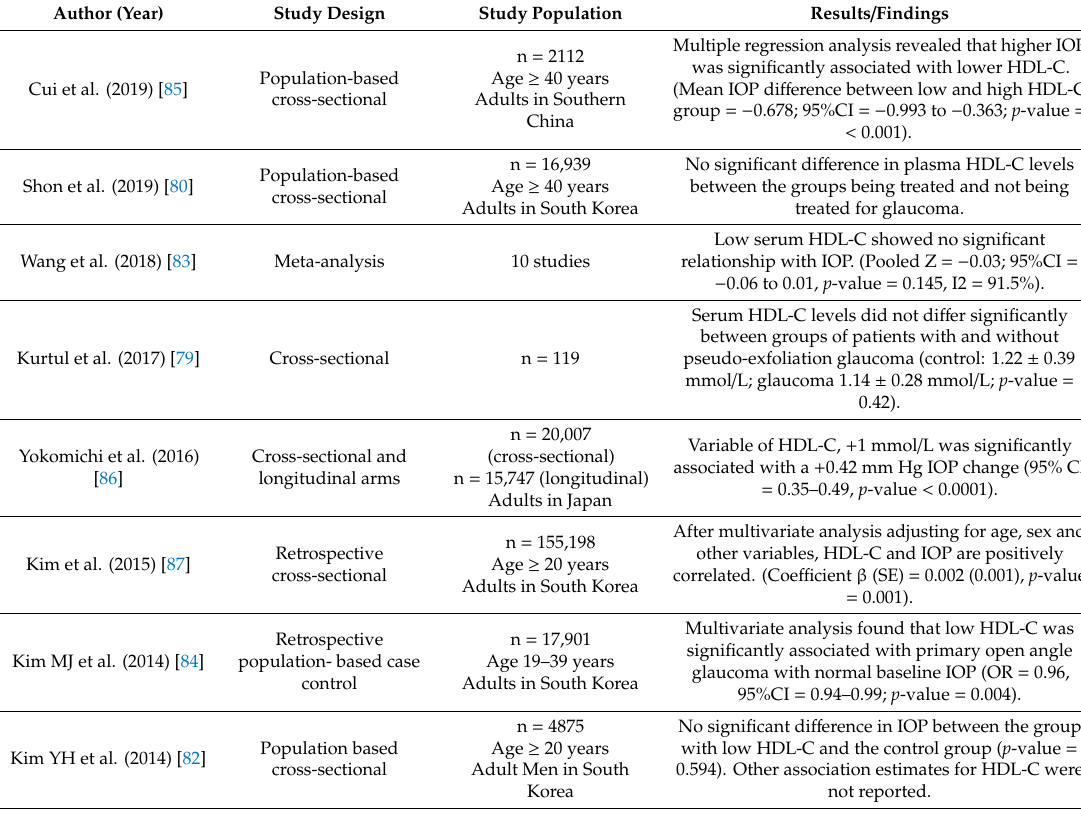
Table 4. HDL-C and Glaucoma—Epidemiological Links from Observational Studies